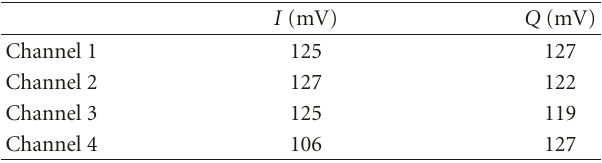
Table 4: Measured I and Q signals amplitudes for 4